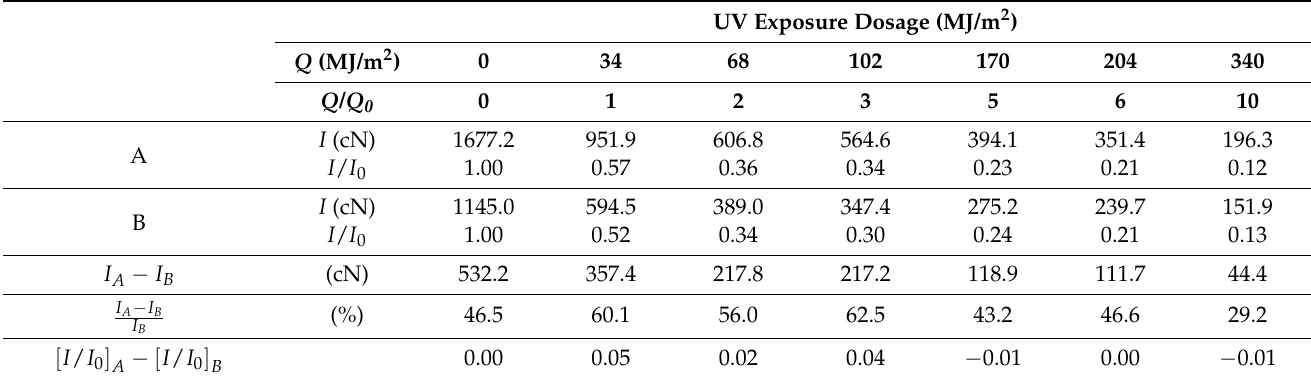
Table 4. Effect of yarn size on tensile strength and retention fraction of tensile strength (Samples A and